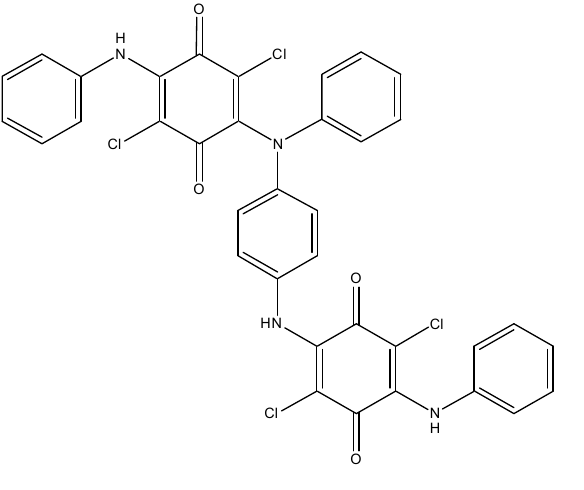
Figure 5. Structure of a DADCB dimer.